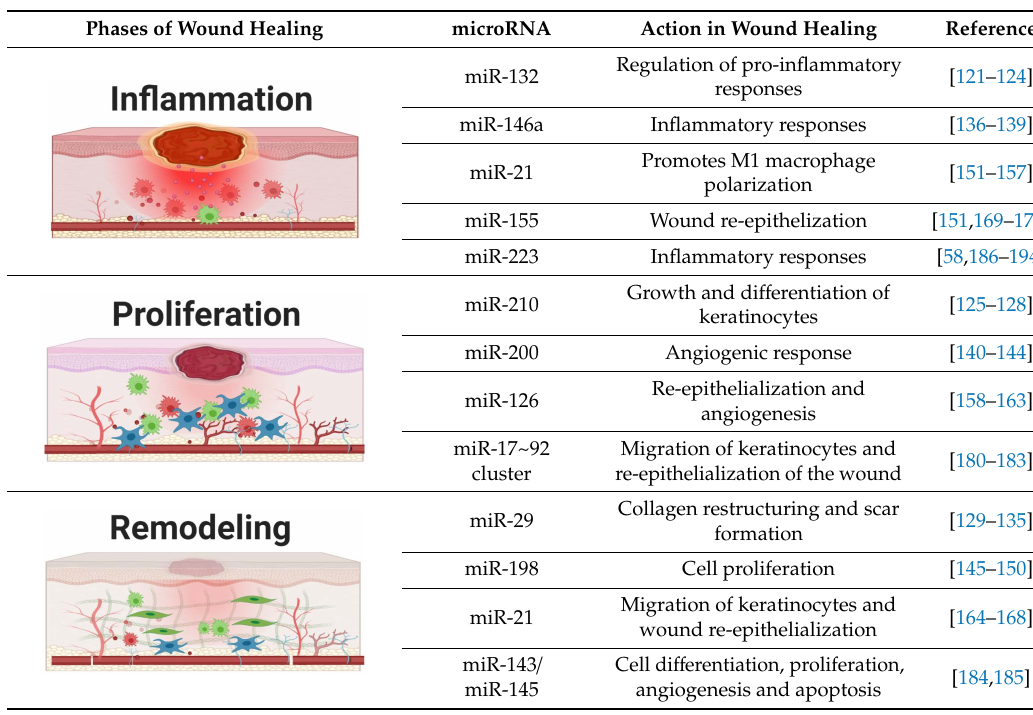
Table 4. Actions of the various miRNA in wound